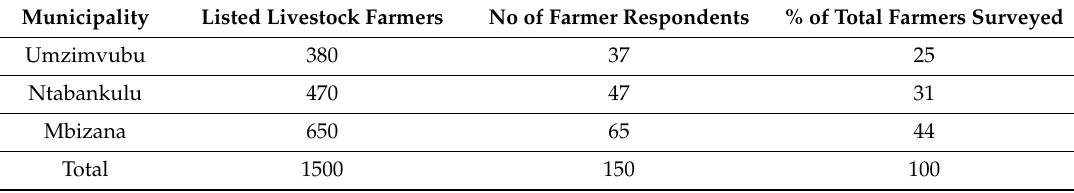
Table 2. Number of farmers sampled from each local municipality.